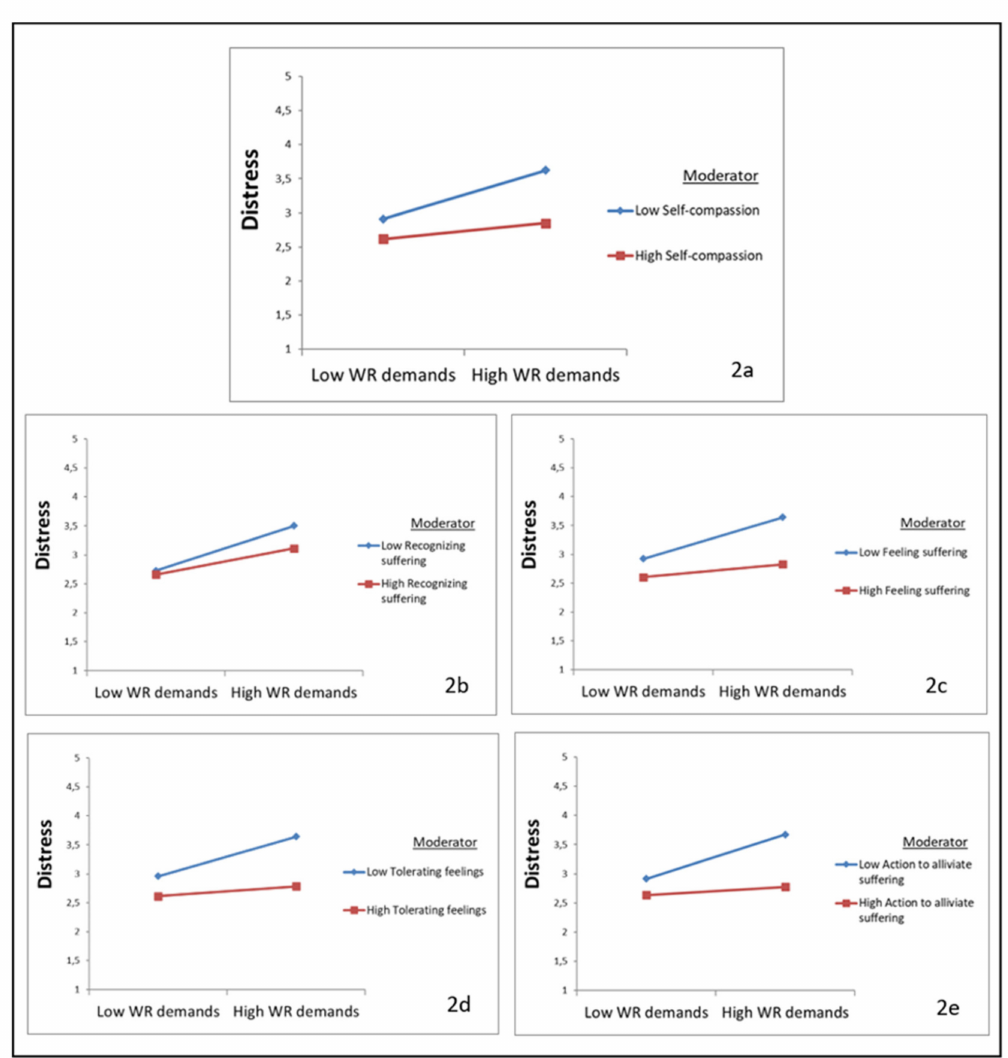
Figure 2. Plots of the interaction between work-related demands (WR demands) and self-compassion (and subscales) in predicting distress. ( a ) self-compassion as moderator; ( b ) Recognizing suffering as moderator; ( c ) Feeling suffering as moderator; ( d ) Tolerating feelings as moderator; ( e ) Action to alleviate